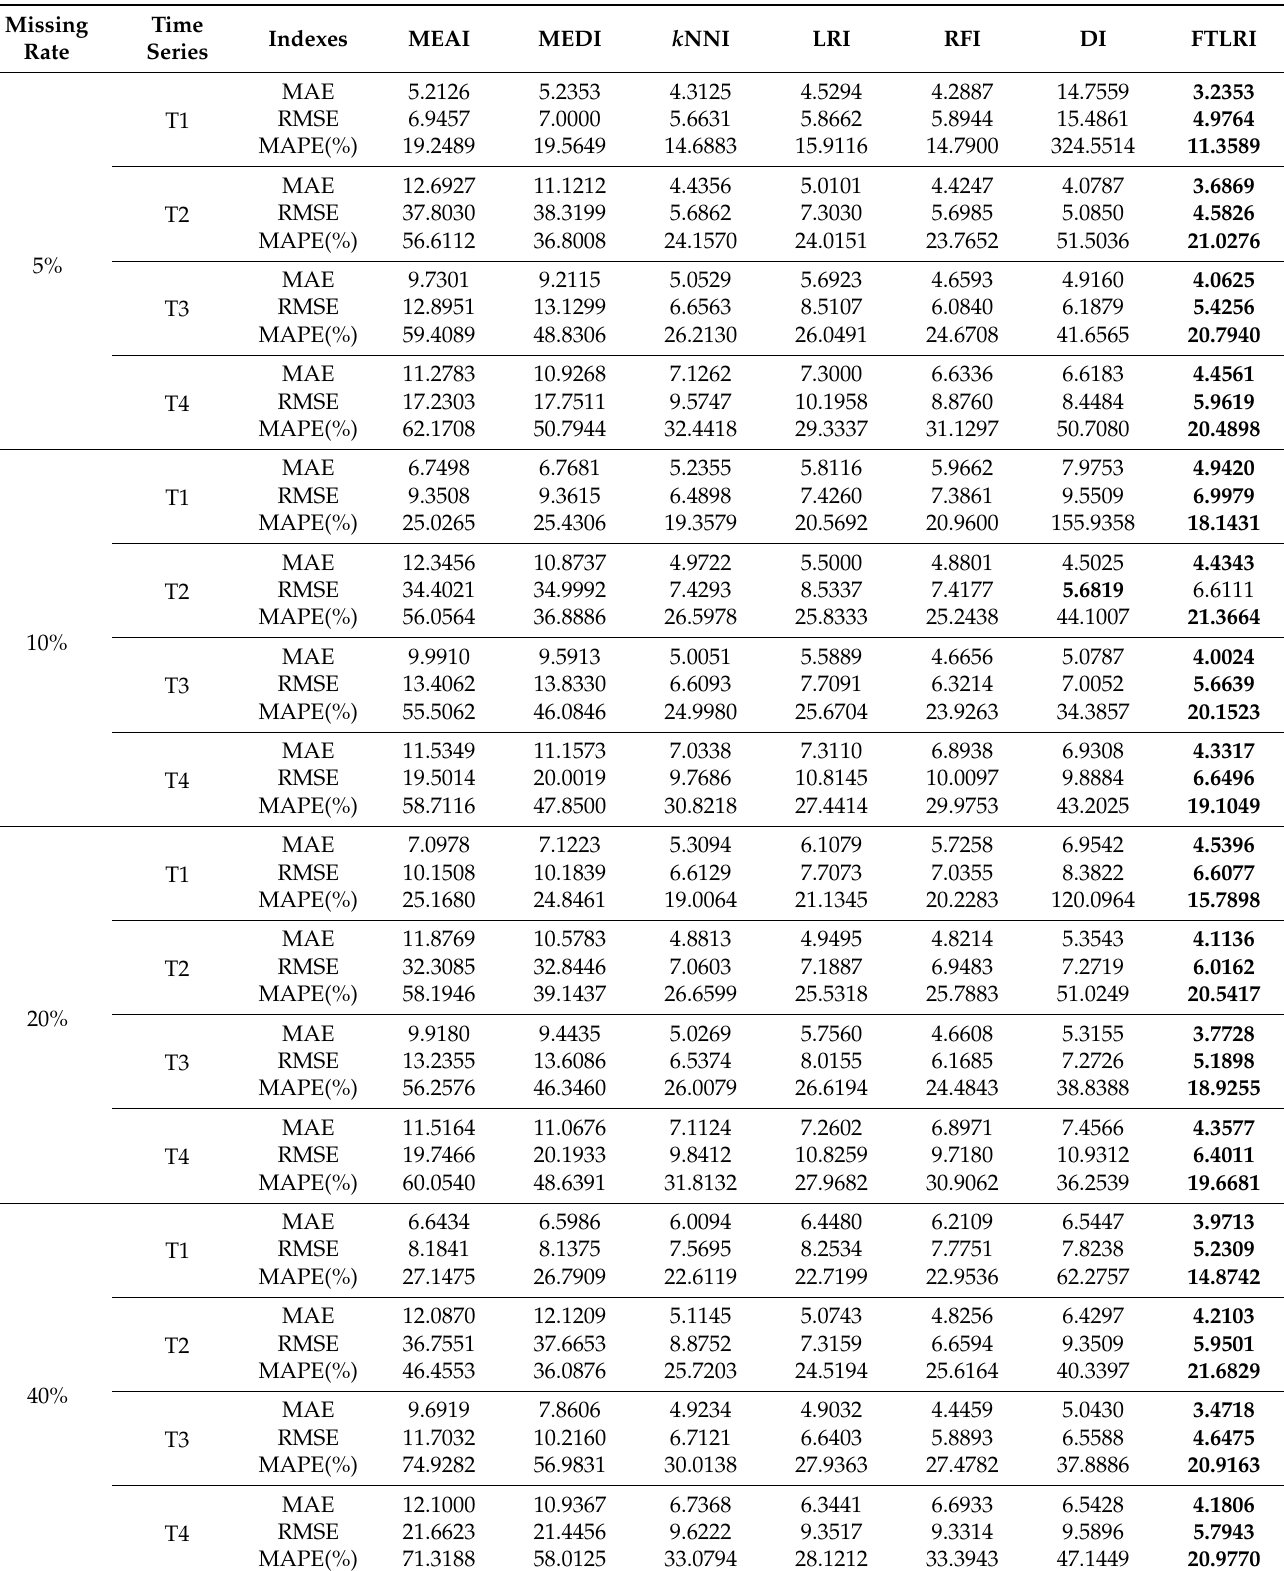
Table 6. Quantitative evaluation of imputation results of PM 2.5 at YZ under different missing rates in the short-/long-term time